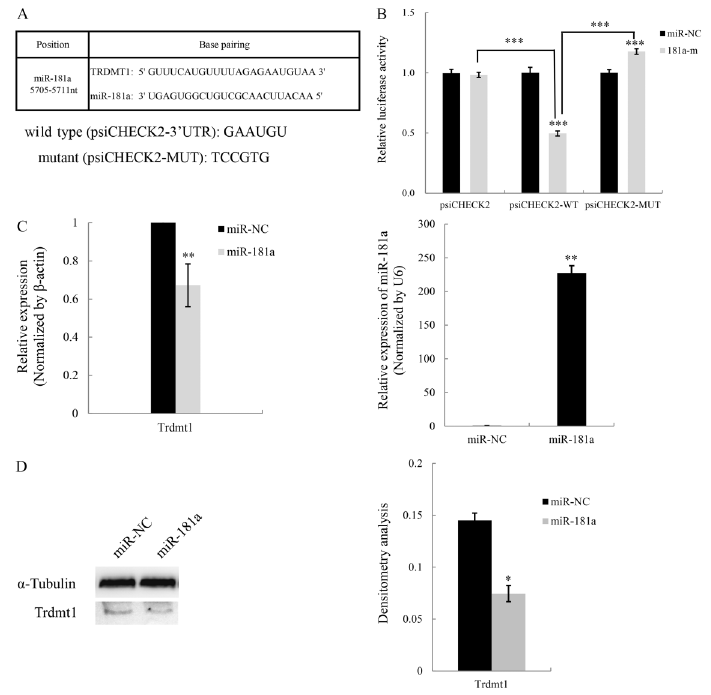
Figure 3. Trdmt1 is a target of miR-181a. A , Seed match of Trdmt1 3 0 untranslated region (UTR) and hsa-miR-181a. The complementary sequences between Trdmt1 and miR-181a are indicated. B , Dual luciferase reporter assay showed that miR-181a mimic reduced relative luciferase activity of Trdmt1-3 0 UTR but not Trdmt1-MUT (mutant) plasmid. C , qPCR analysis of Trdmtm1 mRNA and miR-181a in HL-60 cells transfected with miR-181 mimic and mimic control. D , Western blot analysis and corresponding densitometry analysis of Trdmt1 protein in HL-60 cells transfected with miR-181a mimic or mimic control. Data are reported as means ± SD. *P o 0.05; **P o 0.01; ***P o 0.001 (ANOVA or Student ’ s t -test).